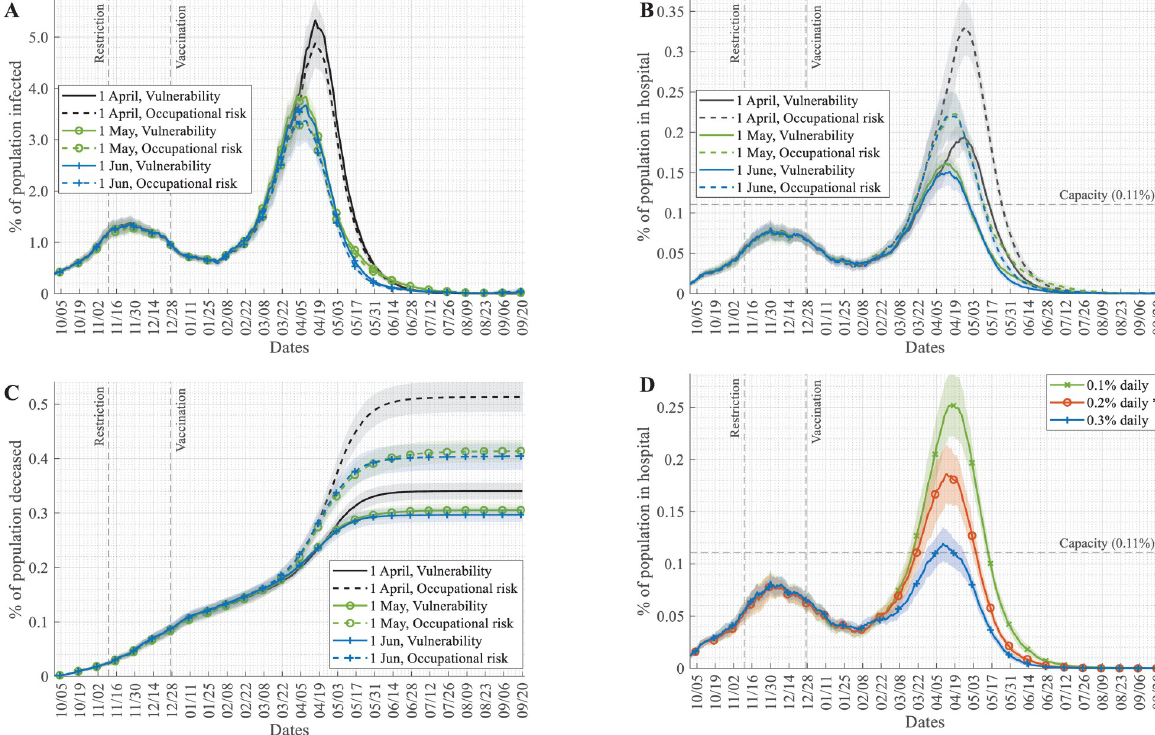
Fig 3. Results of various vaccination and reopening strategies. (A) Percentage of the population infected, (B) percentage of hospitalised COVID- 19 patients in the population, (C) the accumulated number of death events due to COVID-19 scaled to the whole population each day. Panel A-C were simulated with the assumption that daily, 0.2% of the population could be vaccinated. (D) Changes in this daily vaccination rate have major effects on the percentage of hospital patients. (Mean and std. of 30 simulations are